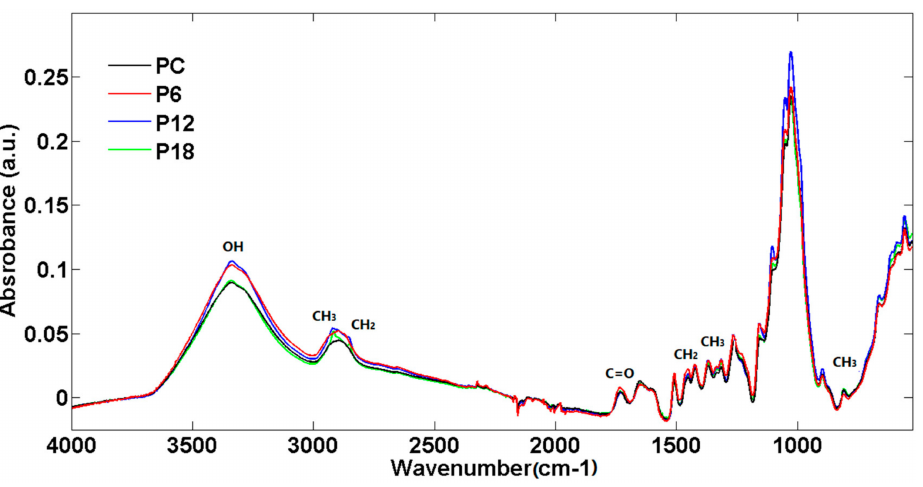
Figure 1. Averaged Infrared spectra of the sample set.